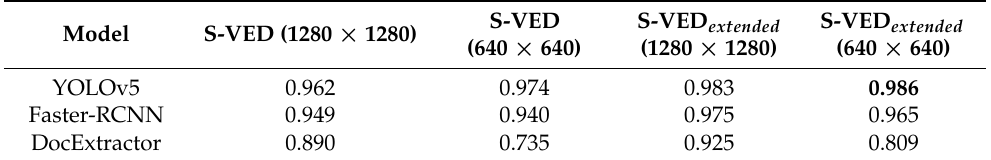
Table 2. Average precision (AP) results for both models for two different image input resolutions.